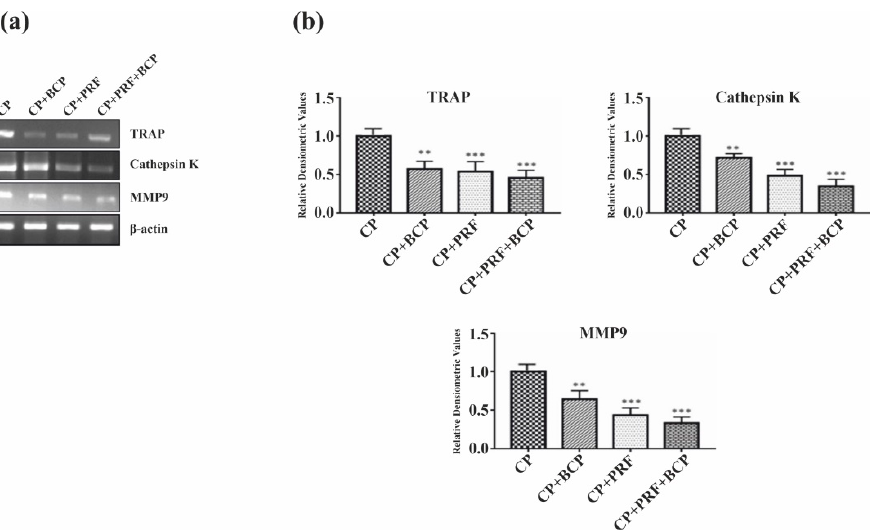
Figure 5. PRF/BCP inhibits osteoclast marker genes. RT-PCR analysis of osteoclastogenic genes TRAP , cathepsin K and MMP-9. ( a ) Representative blot image. ( b ) Relative densitometric analysis in histograms. Results are expressed as mean ± SD. Comparisons were made among CP and BCP, CP and PRF, and CP and PRF/BCP combination. (** p < 0.01; *** p <